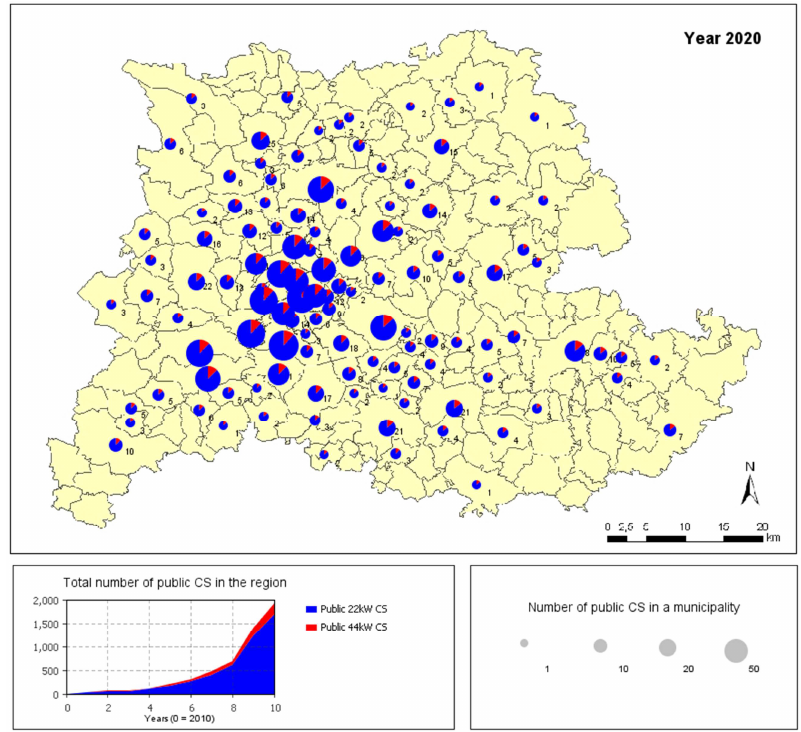
Figure 10. Development of public charging infrastructure until 2020 in the “higher quotas” scenario